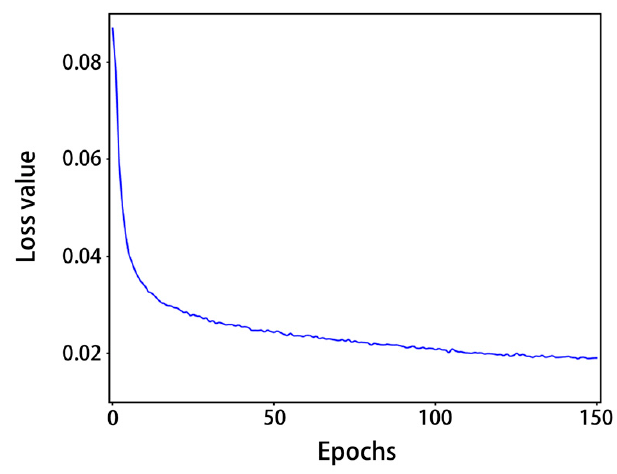
Figure 8. Loss value